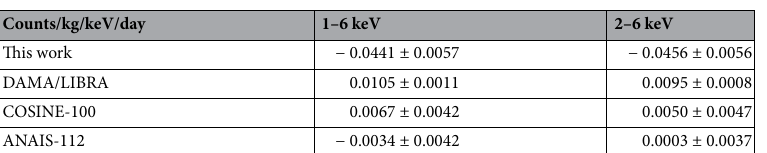
Table 3. Annual modulation amplitudes from various experiments. The amplitudes of the annual modulation fits using the DAMA-like method to the COSINE-100 3 years data (this work) are compared with results from DAMA/LIBRA 15,16 , COSINE-100 8 , and ANAIS-112 9 in both 1–6 keV and 2–6 keV